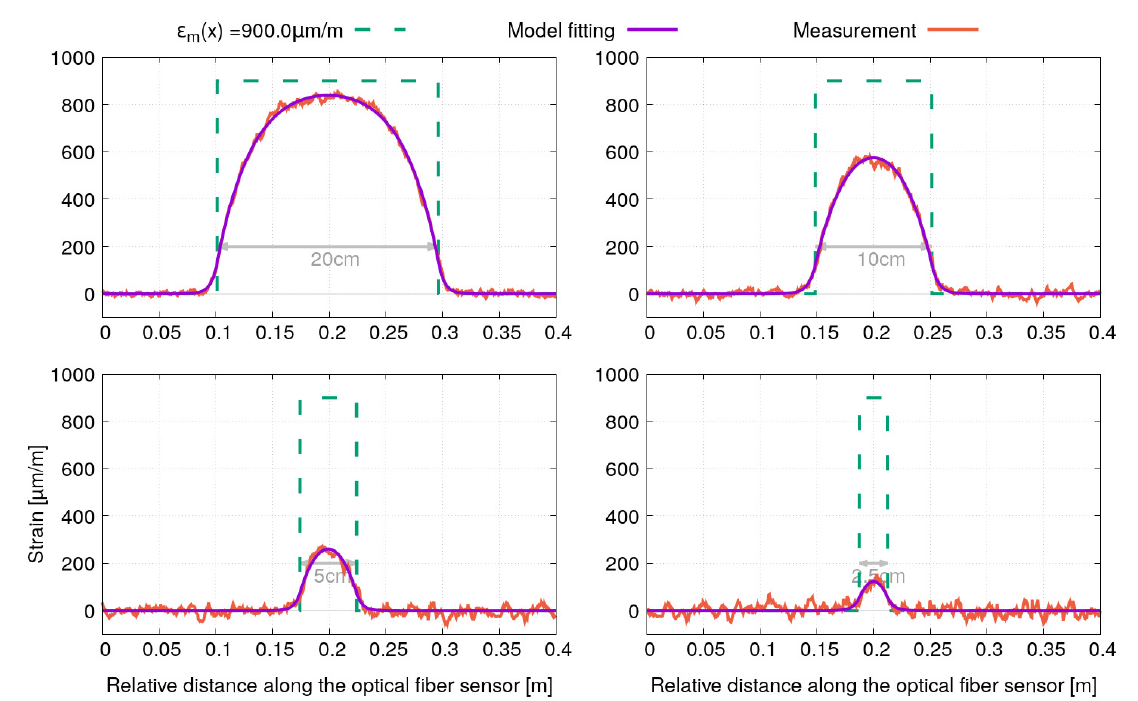
Figure 10. Fitting of the strain profiles obtained for the sample instrumented by optical fibers with acrylate coating under tensile test ( σ m = 180 MPa).